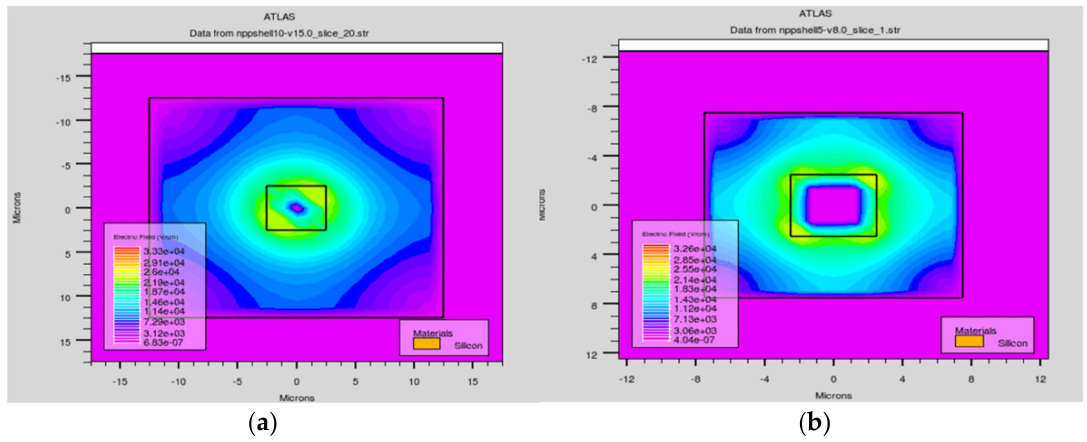
Figure 6. Electric field profiles of the detector along Z axis when z = 103 µ m with an electrode spacing of ( a ) 10 µ m and ( b ) 5 µ m.